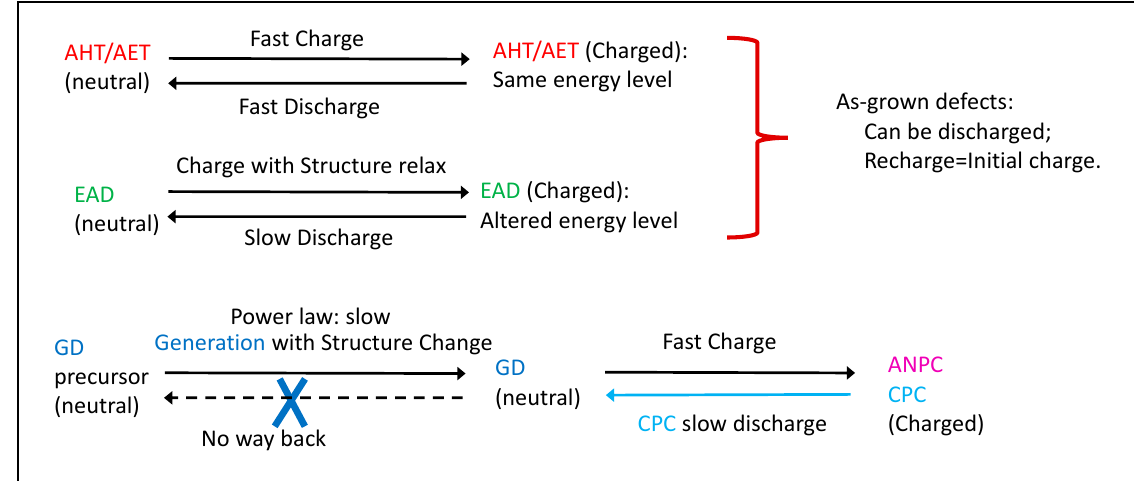
Figure 30. A framework for the defects responsible for bias temperature instabilities.